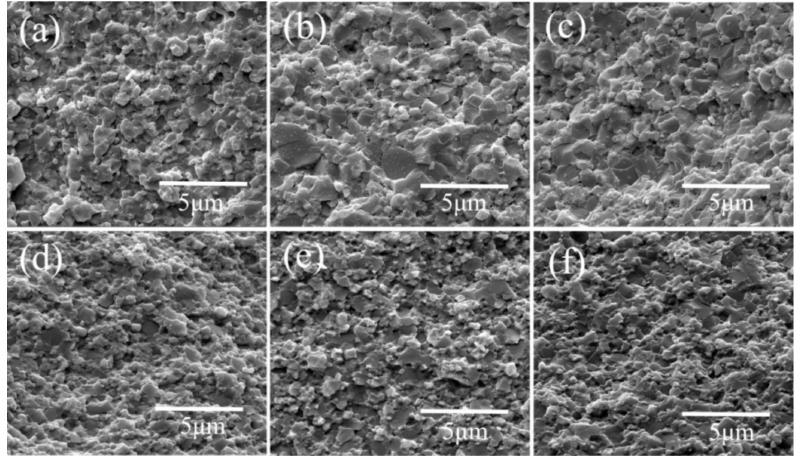
Figure 3. Comparative analysis showing the SEM images of LiFePO 4 samples: ( a ) LFP-SPS-AC-Top, ( b ) LFP-SPS-AC-Middle, ( c ) LFP-SPS-AC-Bottom, ( d ) LFP-SPS-DC-Top, ( e ) LFP-SPS-DC-Middle, ( f )